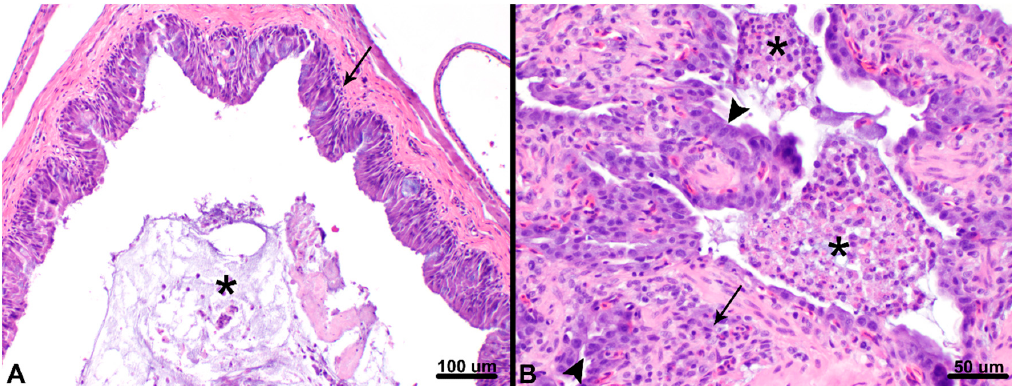
Figure 2. Bronchointerstitial pneumonia and rhinitis with proliferative and catarrhal change in a veiled chameleon (VC1). ( A ) Histopathology of the nasal cavity revealed abundant mucus admixed with low numbers of sloughed epithelial cells, and heterophils (asterisk) with the nasal lumen. Proliferation and lymphocytic infiltration of the nasal mucosa (arrow) was present throughout. Hematoxylin and eosin (HE), 100 × magnification, 100 µ m scale bar. ( B ) Histopathology of the lungs revealed faveolar lumena (asterisks) and bronchiolar air spaces containing numerous, large accumulations of heterophils admixed with sloughed epithelial cells, mucus and cellular debris. Multifocally, there was marked hypertrophy and hyperplasia of type II pneumocytes (arrowheads) and expansion of interstitial spaces by mononuclear and heterophilic inflammation (arrow). The trachea (not shown) was similarly a ff ected. HE, 200 × magnification, 50 µ m scale